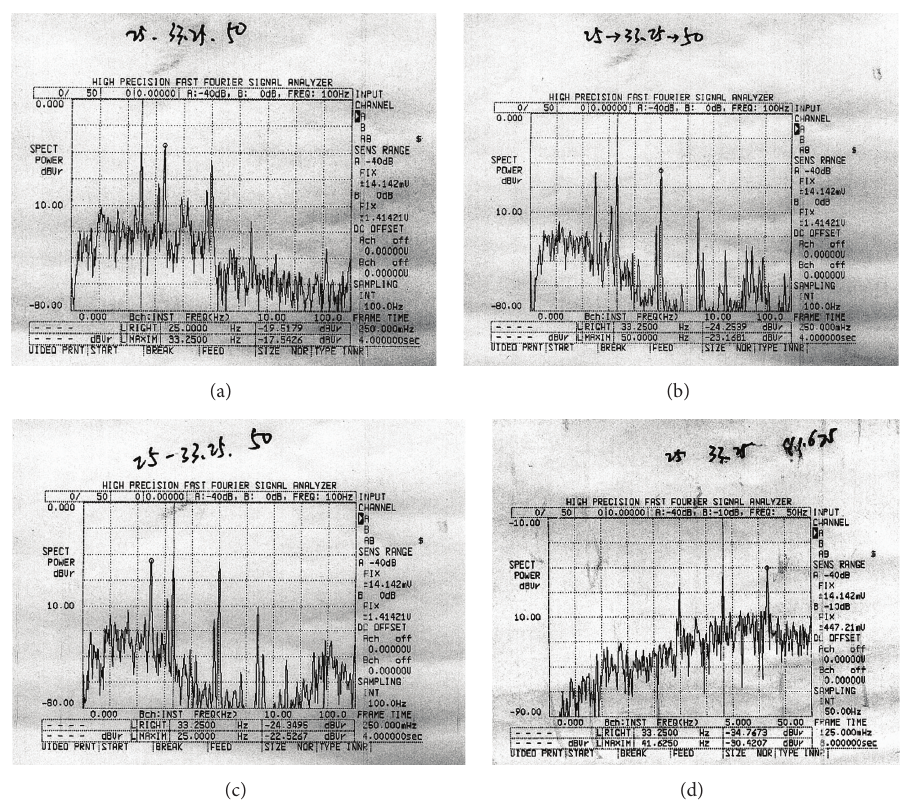
Figure 10: Measured signal of spindle system in different conditions. (a) Case is turning on all, that is, the air pump, the oil pump, and the electronic control system; (b) case is just turning on the air pump; (c) case is turning on the air pump and oil pump; (d) case is turning on the air pump and electronic control